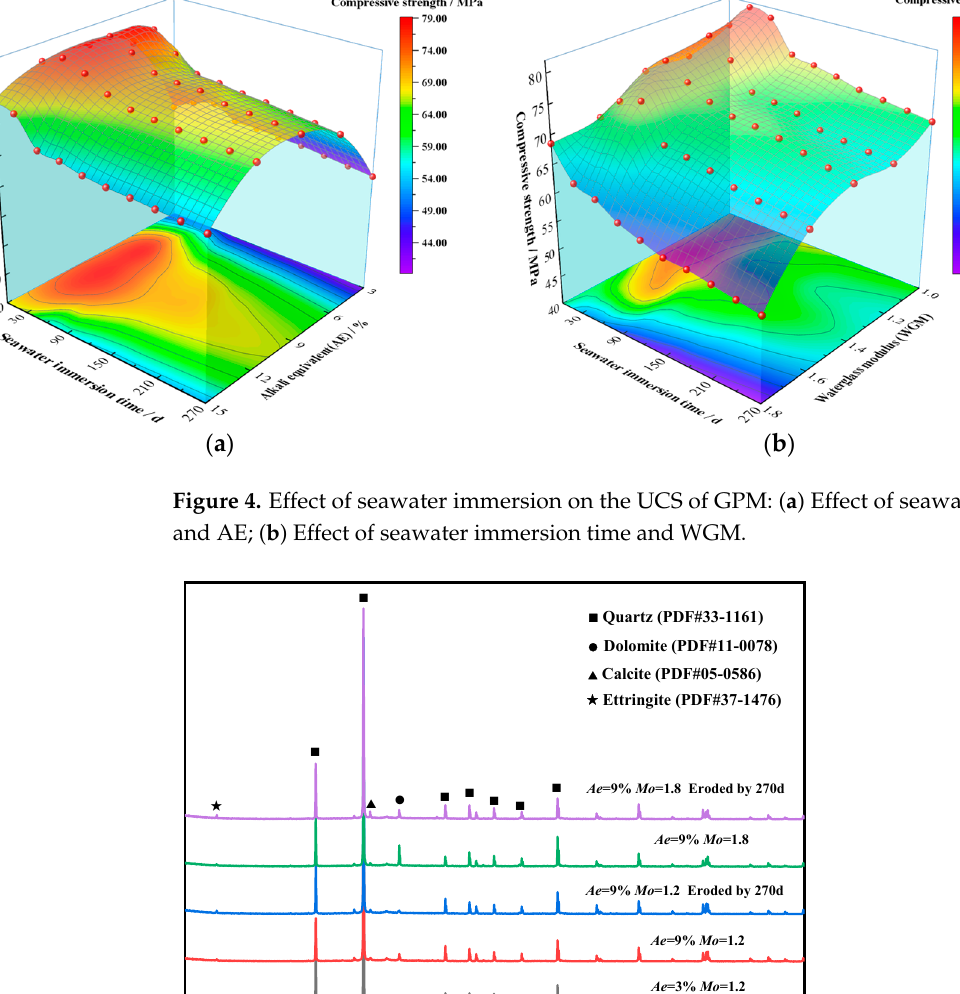
( b ) Figure 6. Compressive loss rate of GPM after 270 d of seawater immersion: ( a ) The impact of AE; ( b ) The impact of WGM.